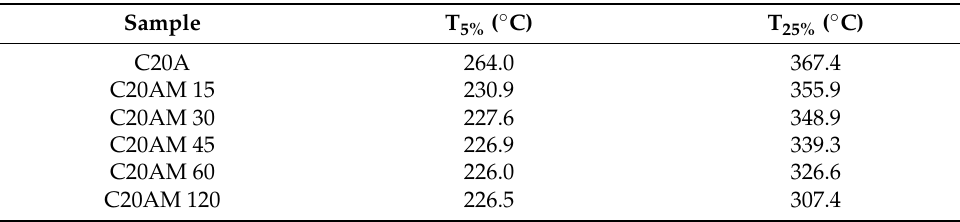
Table 3. Thermal properties of C20A nanoclay modified at different times.